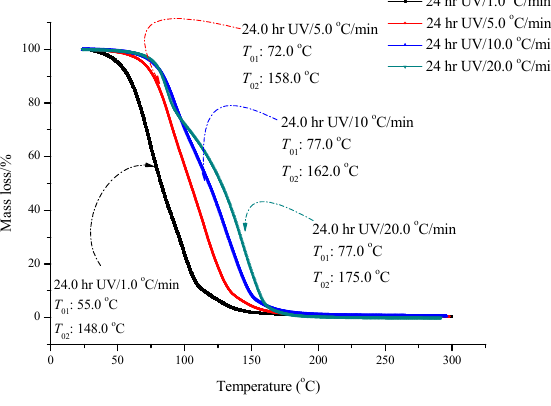
Figure 5. TG thermal curve of ADVN with UV/24 h at heating rates of 1, 5, 10, and 20 °C/min.